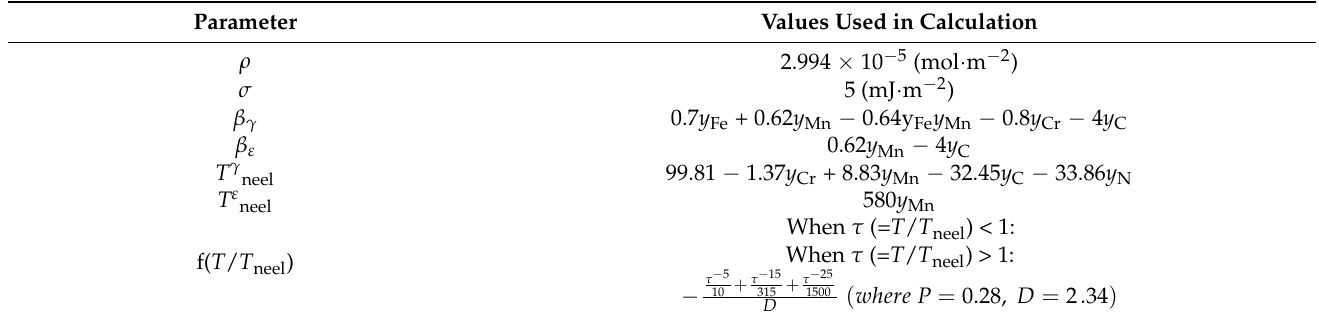
Table 1. The values used for the estimation of the SFE in the investigated TWIP steel. Parameter Values Used in Calculation